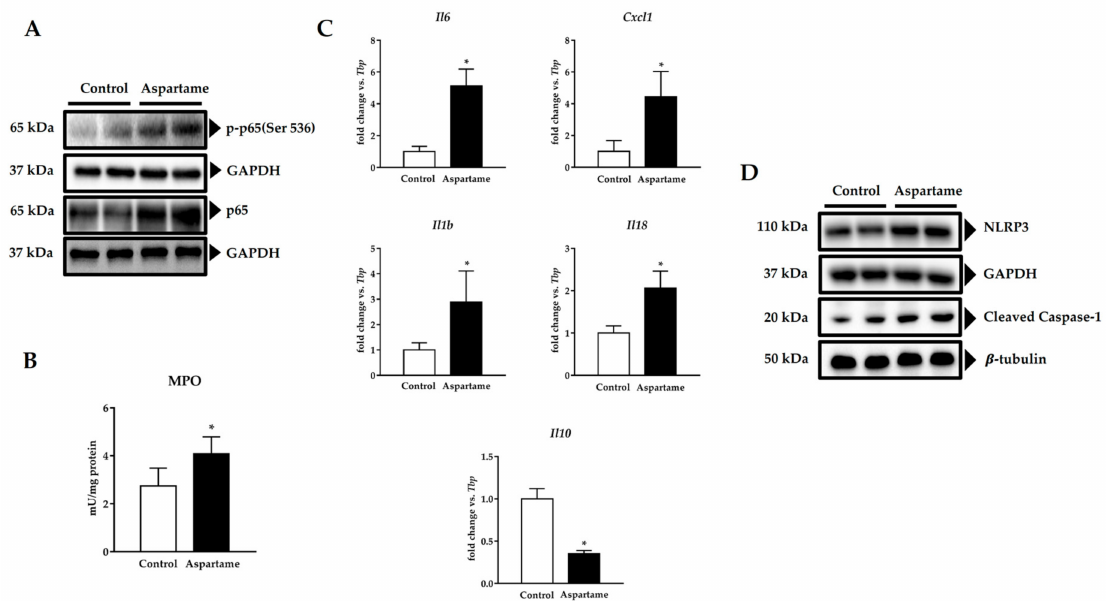
Figure 4. Representative image of Western blotting of phospho-p65 (Ser536) and p65 in the livers of control and aspartame- treated mice ( n = 4, each group). Glyceraldehyde-3-phosphate dehydrogenase (GAPDH) was used as a loading control ( A ). Myeloperoxidase (MPO) activity in the livers of control and aspartame-treated mice ( n = 6, each group) ( B ). mRNA relative expression of cytokines interleukin (IL) 6 Il6 , chemokine (C-X-C motif) ligand 1 ( Cxcl1 ), Ilb1 , Il18 , and Il10 versus Tbp measured by RT-qPCR in the livers of control and aspartame-treated mice ( n = 6, each group) ( C ). Representative images of Western blotting of NOD-like receptor containing protein 3 (NLRP3) and cleaved caspase 1 in the livers of control and aspartame-treated mice ( n = 4, each group). GAPDH and β -tubulin were used as the loading controls, respectively ( D ). The statistical difference is indicated as follows: * p < 0.05 versus